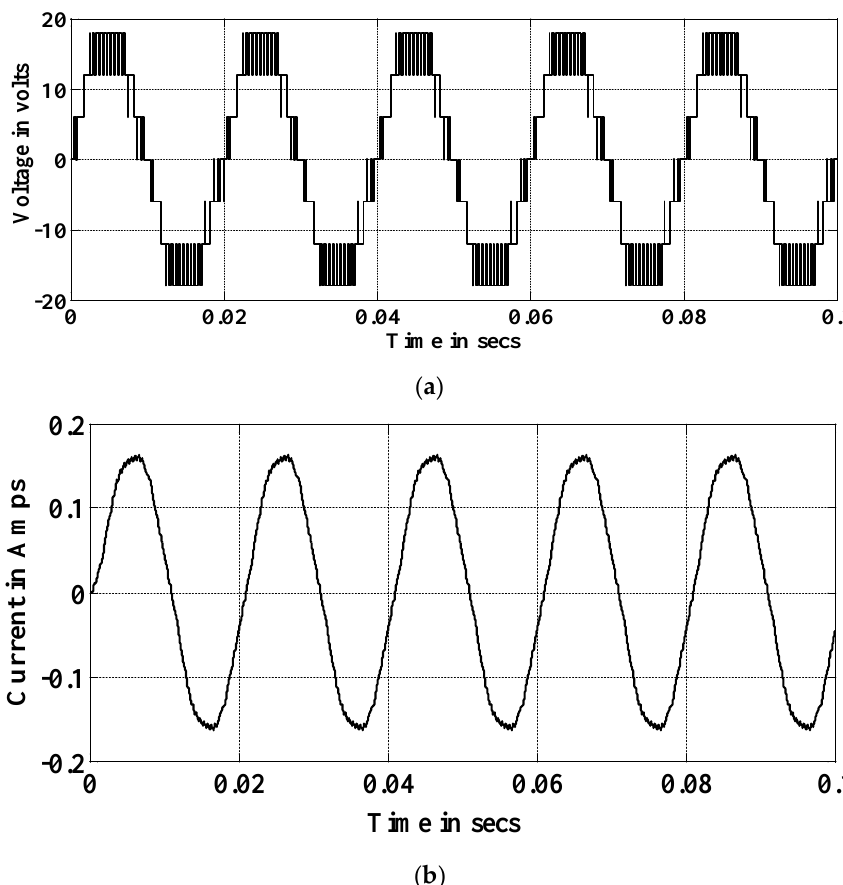
Figure 13. Output waveform for the VFPWM strategy. ( a ) Voltage; ( b ) Current.